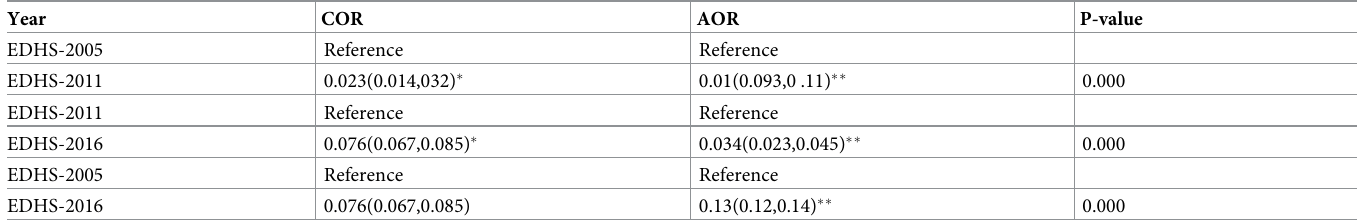
According to Table 4 description, The decomposition analysis model has taken into account the differences in the features (compositional factors) and the differences due to the effect of characteristics. Only 29.2% of the overall anemia change was due to differences in Table 3. The time predictor of anemia among study subjects from 2005-2016(N =